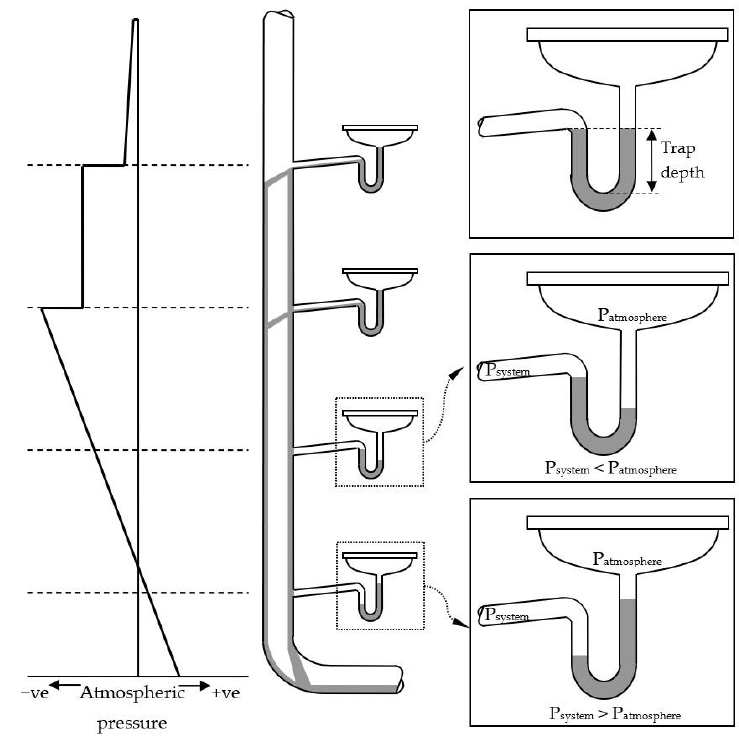
Figure 1. Pressure profile for a single-stack system with two active branches . All pressure phenomena in the air propagate at the local speed of sound, adequately approximated to 340 ms −1 . This is the speed at which a pressure change (transient) will propagate an appropriate air movement to or from the source. In the most extreme case of an event near the bottom of an open stack, a transient will travel to the open-top, reflect with opposite sign (−1 reflection coefficient) and travel back down again, giving rise to the pipe period, t p , which is the time taken for a generated transient to travel to a reflecting boundary and return to the source, defined by Equation (1):